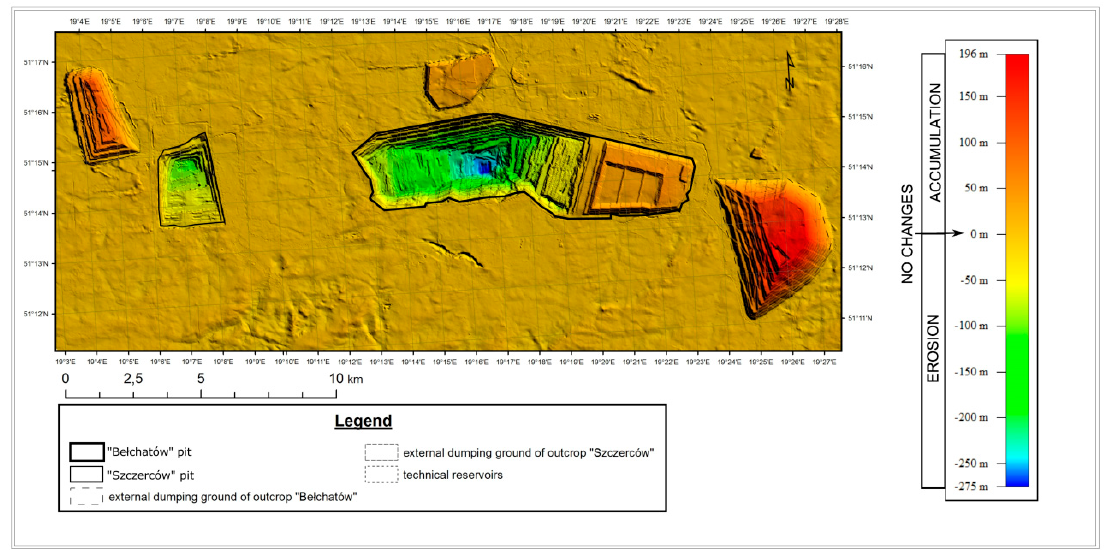
Figure 8. Raster image presenting topography elevation differences between the pre-investment period and the current state. Source: Own elaboration.